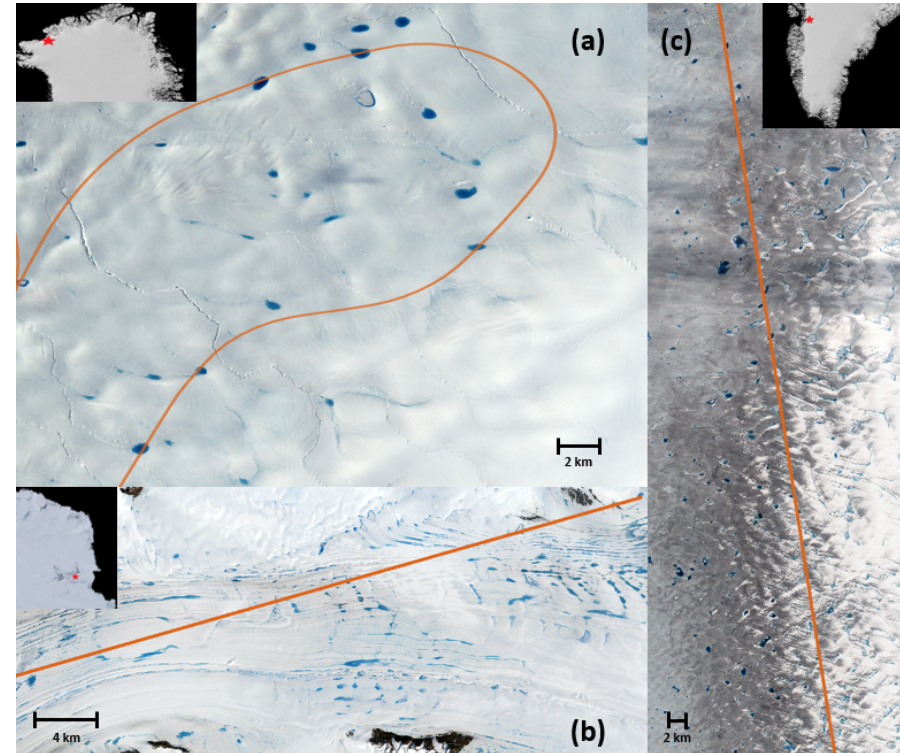
Figure 2. True-color Landsat-8 composites of Hiawatha Glacier on 18 July 2017 (a) , the Amery Ice Shelf on 1 January 2019 (b) , and the western Greenland ablation zone on 17 June 2019 (c) . Flight tracks for Operation IceBridge (a) and ICESat-2 (b, c) are shown in dotted